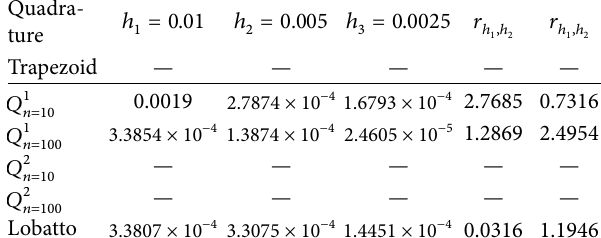
Table 5: Relative error for different meshes. Example 4,